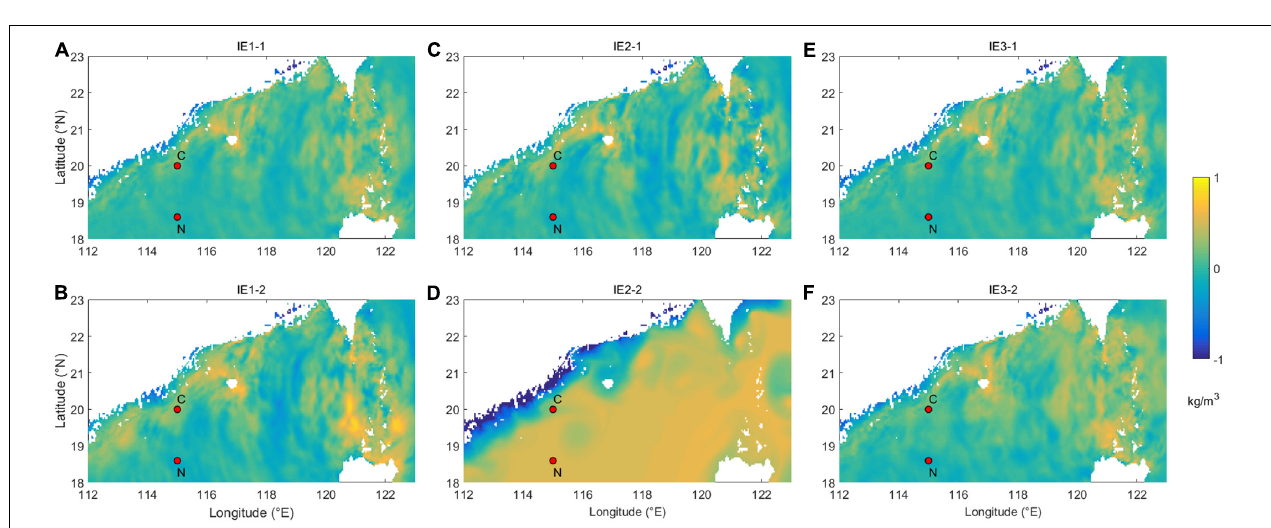
FIGURE 7 | Distributions of eastward baroclinic current velocities in (A–F) diurnal and (G–L) semidiurnal frequency bands.